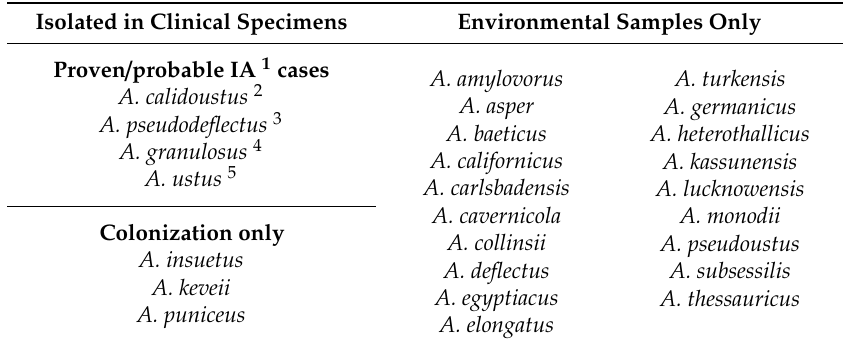
Table 1. The 26 Aspergillus species of section Usti and their pathogenic role in humans. Isolated in Clinical